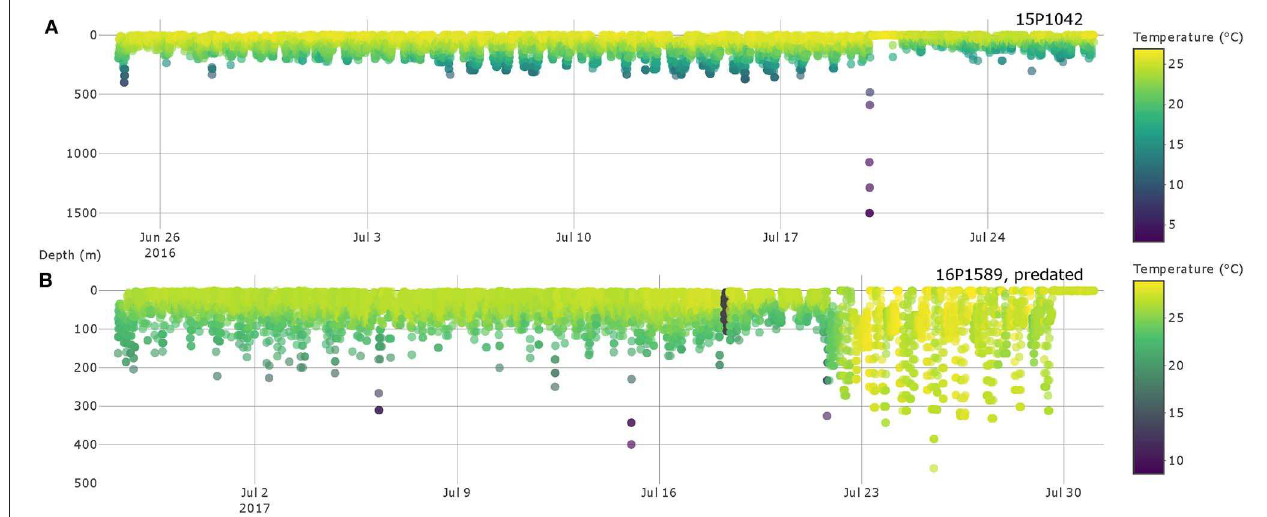
FIGURE 6 | Depth and temperature profiles of yellowfin tuna 15P1042 (A) and 16P1589 (B) with possible predator interactions. Colors represent water temperature and are scaled individually for easier identification of possible